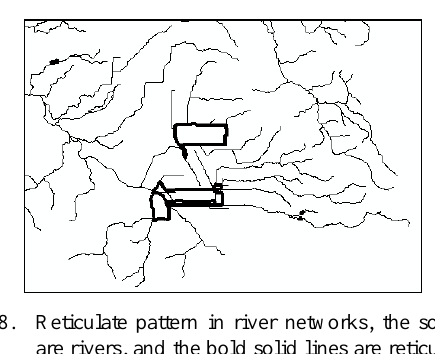
Figure 8. Reticulate pattern in river networks, the solid lines are rivers, and the bold solid lines are reticulate part